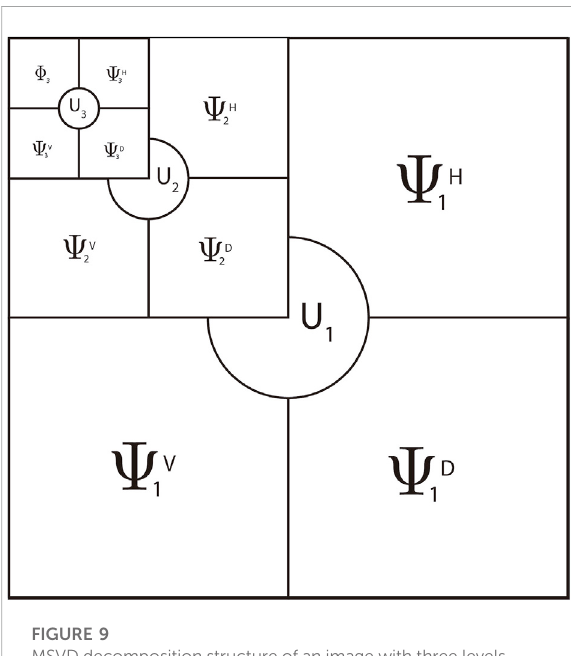
FIGURE 9 MSVD decomposition structure of an image with three levels of decomposition (Naidu,